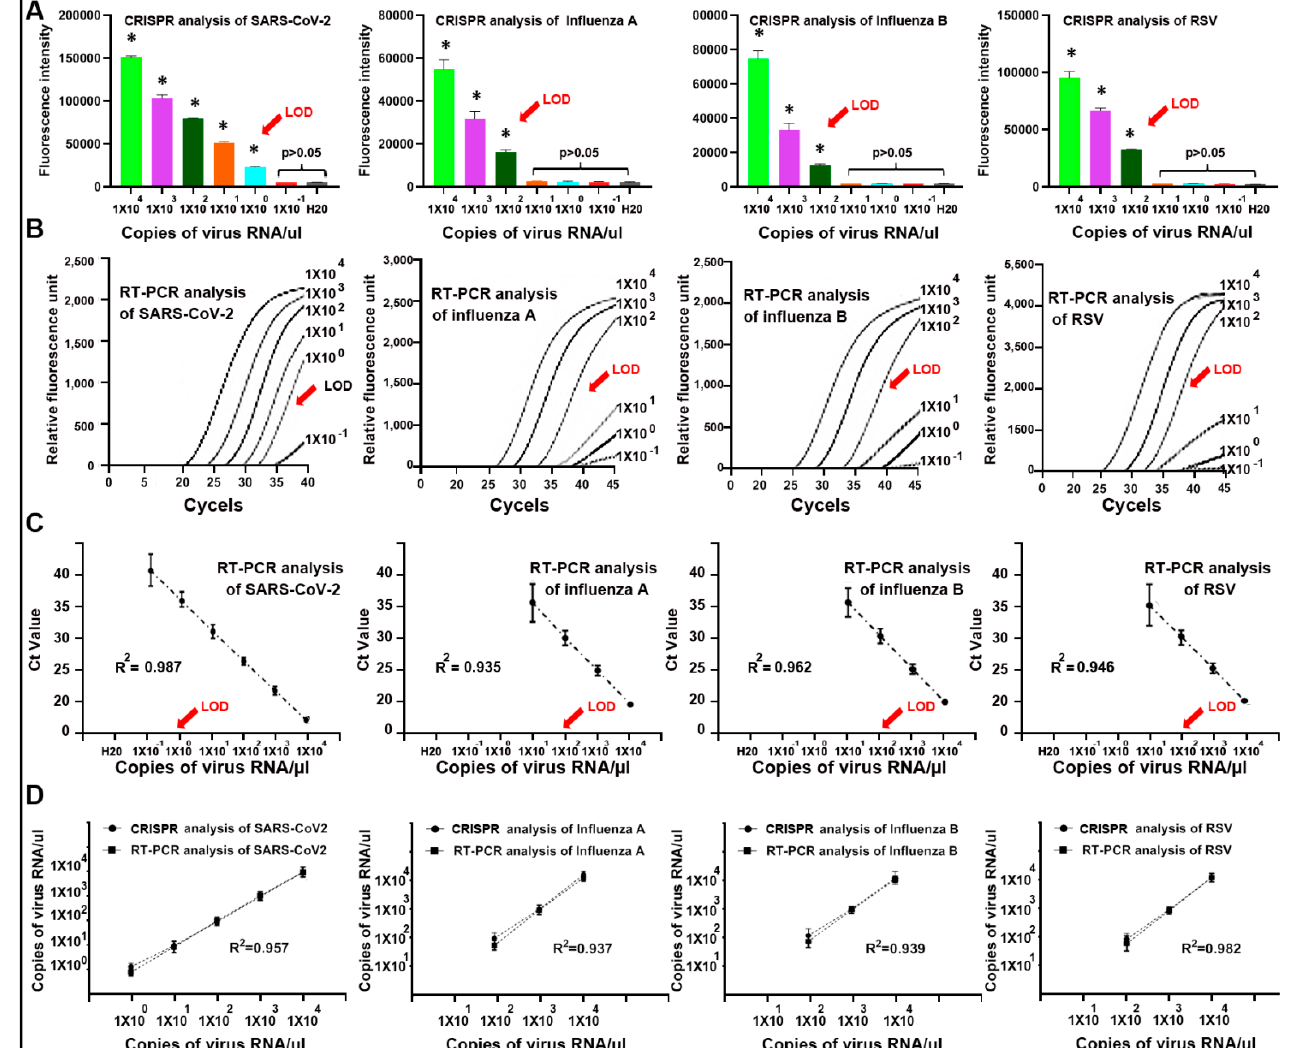
Figure 4. The sensitivity of CRISPR-Cas12a and RT-PCR for detecting SARS-CoV-2, influenza A and B, and RSV in serially diluted RNA standard samples. ( A) The LOD of CRISPR for detecting the viruses was 1–100 copies/µl (* p < 0. 01). The X-axis shows the serially diluted concentrations (from 10 4 to 0.1 copies/µl) of the RNA standard samples that were tested. The Y-axis indicates the fluorescence intensity of each sample read on the fluorescence plate reader. The error bars represent the standard deviation from the mean of the fluorescence intensity generated from ten replicates in each sample. ( B ) Amplification curves of RT-P CR analysis of the serially diluted RNA samples. Amplification plots were created when the relative fluorescence unit (Y-axis) from each sample was plotted against the cycle number (X-axis). ( C ) The high linearity (R 2 = 0.902–0.997) of all standard curves of the four types of viruses analyzed by RT-PCR. The X-axis indicates the serially diluted RNA samples that were tested. The Y-axis shows the cycle number of RT-PCR. The error bars represent the standard deviation from the mean of cycle number of RT-PCR generated from ten replicates in each sample. ( D ) Linear regression analysis shows that the CRSIPR and RT-PCR assays had great agreement for detection of the viruses (All R 2 > 0.90, p < 0.01). The X-axis shows the serially diluted RNA samples tested. The Y-axis displays the copies of virus RNA per µl measured by CRSIP or RT-PCR in each of the serially diluted RNA samples. The error bars represent the standard deviation from the mean of copy number generated from ten replicates per concentration.